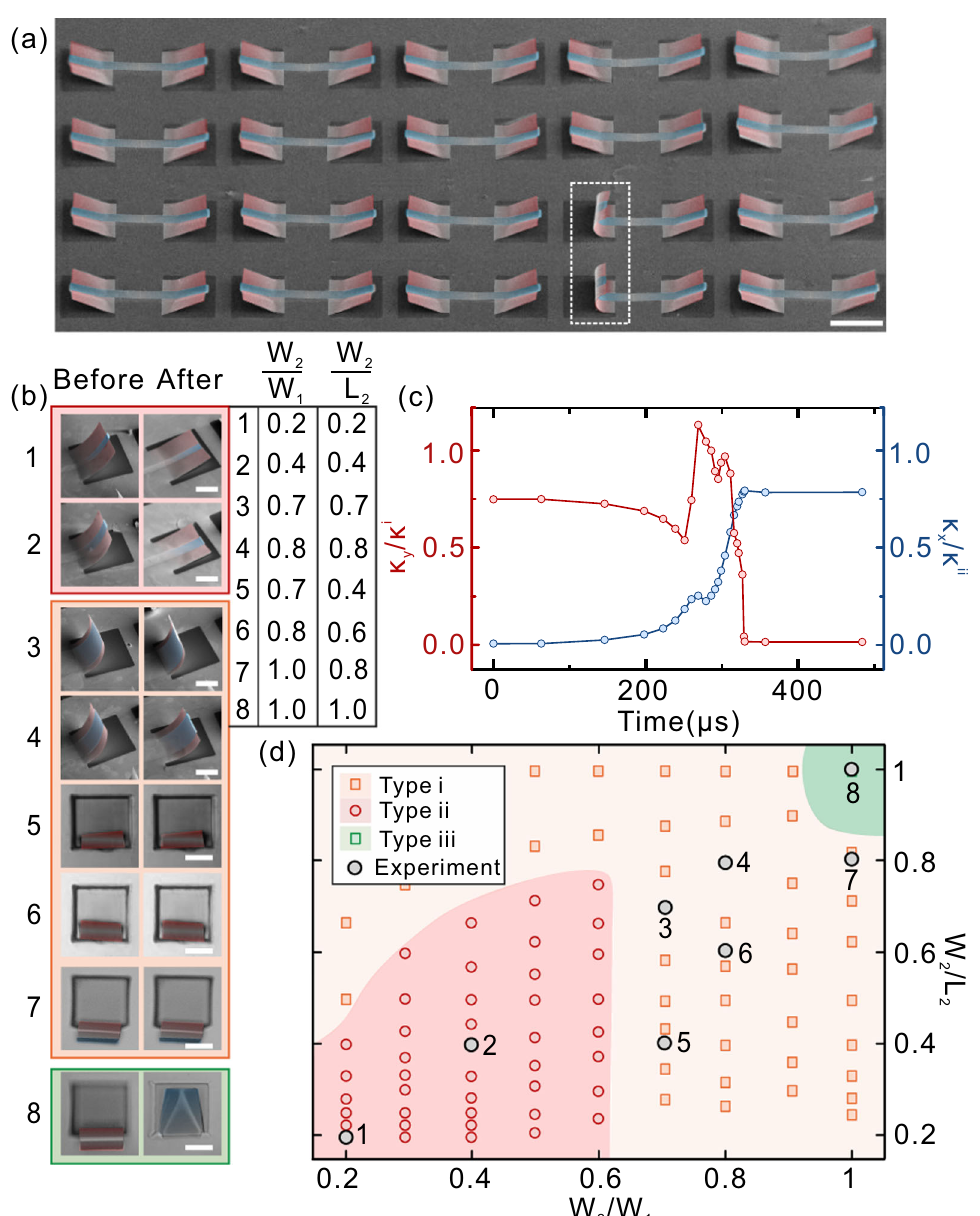
Fig. 2 Design strategy for creating non-volatile recon fi guration. a SEM image of an array of the curved-up shape with orthogonal curvature through anti- symmetric bending. The white dashed line surrounds two of the folded shape. The scale bar is 100 μ m. b SEM (1 – 4) and optical images (5 – 8) of eight samples before and after shape morphing with geometric parameters shown in the attached table. W 2 / W 1 and W 2 / L 2 represent the ratio of the upper layer width to lower layer width, and upper layer width to length, respectively. The scale bar is 50 μ m. c The variations of κ versus the time from FEM. d Phase diagram of favorable shape-morphing status related to W 2 / W 1 and W 2 / L 2 . Gray circles are the results of experiments in b . Yellow (pure bending), red (anti-symmetric bending), and green (cross-ply bending) dots are the results from